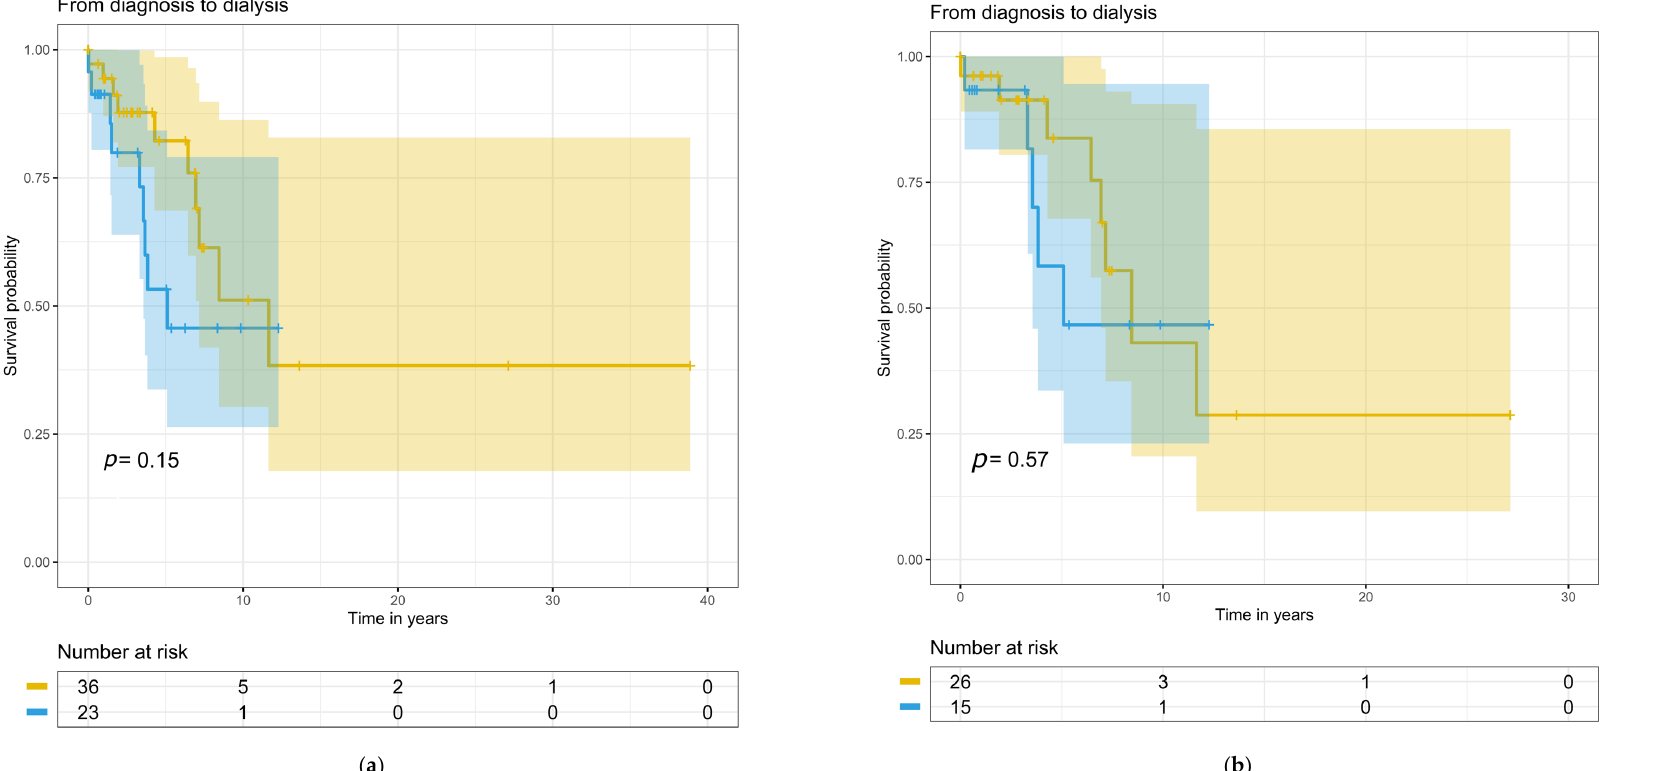
Figure 4. Longitudinal changes from diagnosis to dialysis with numbers at risk: ( a ) for the entire study population; ( b ) for primary MPGN and C3G cases. The yellow line indicates IC-MPGN and the blue line indicates C3G. Colored areas indicate confidence interval and small vertical lines indicate the end of follow -up.